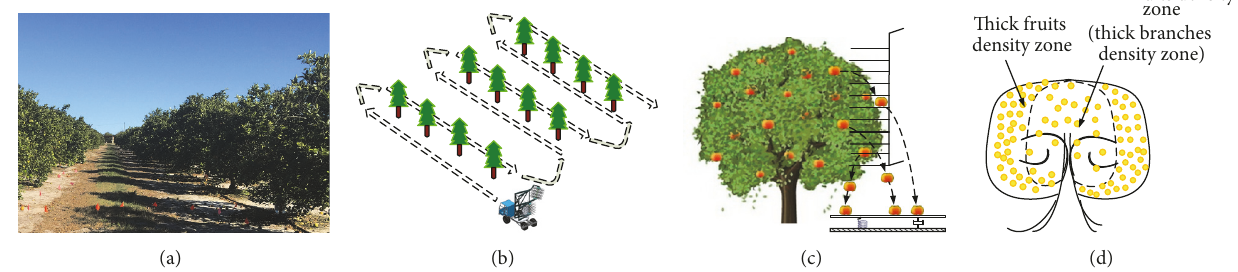
Figure 1: (a) A picture of citrus grove, (b) a schematic drawing of canopy shaking harvester working along the row of citrus groves, (c) a schematic drawing of shaking harvesting, and (d) a schematic drawing of fruits and branch zones.